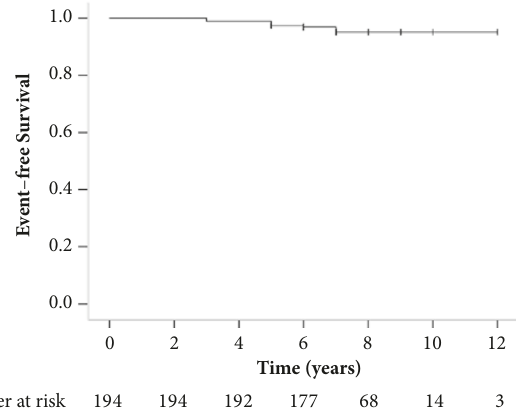
Figure 1: Kaplan-Meier curve of the cumulative incidence of diverticular